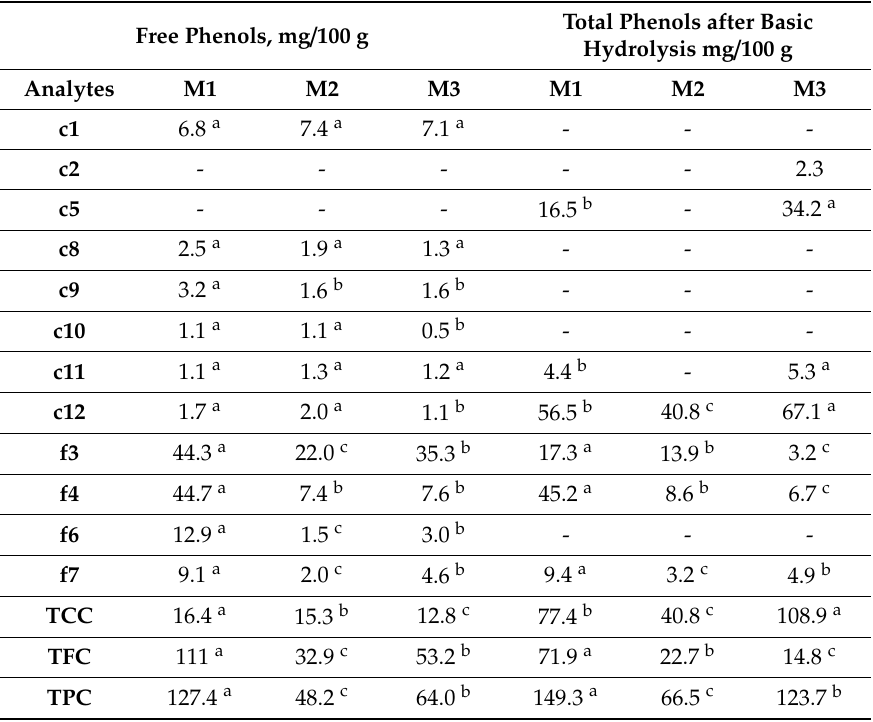
Table 2. Free phenols and total phenols obtained after basic hydrolysis.